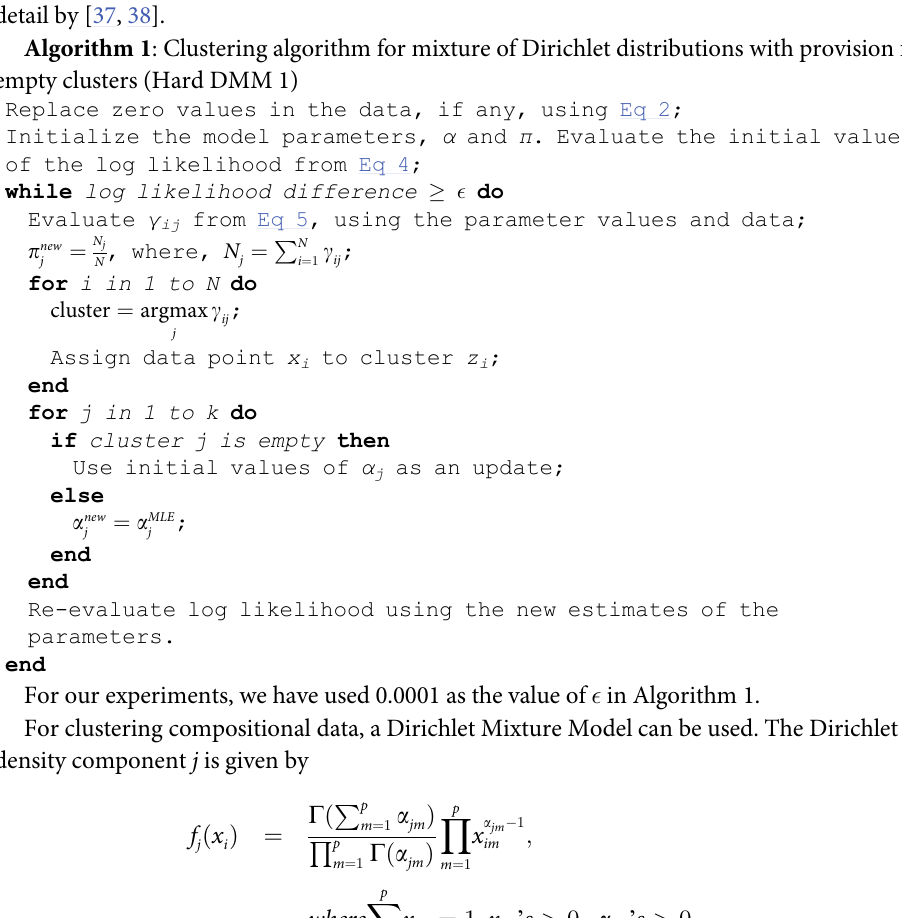
Algorithm 1 : Clustering algorithm for mixture of Dirichlet distributions with provision for empty clusters (Hard DMM